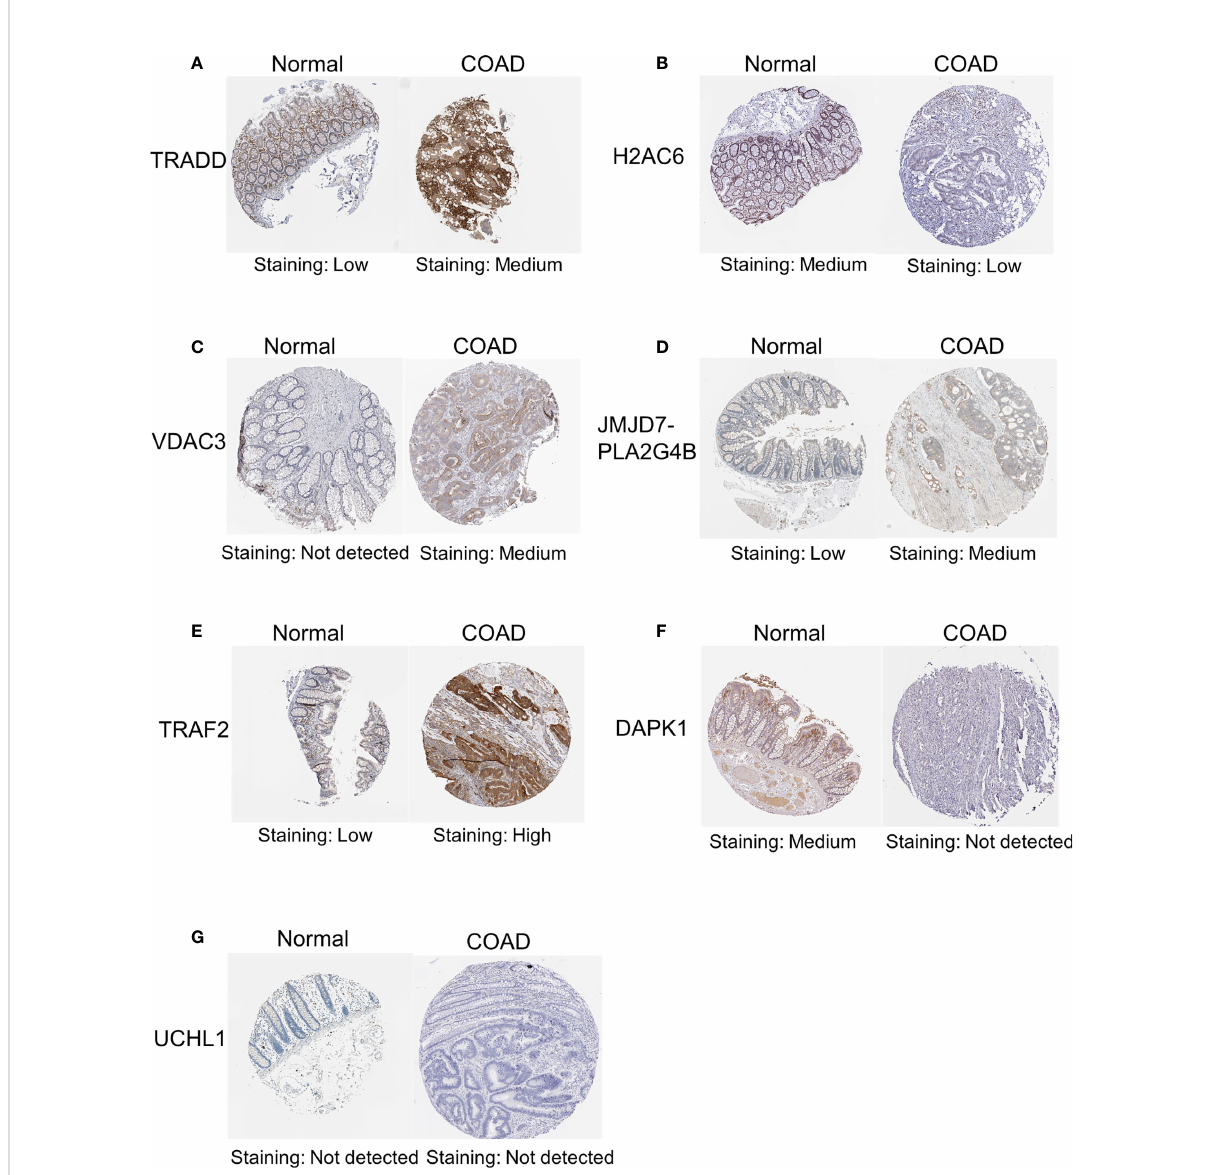
FIGURE 12 IHC analysis of the protein expression of necroptosis-related candidate genes in COAD and normal tissues in the HPA database. The protein expression levels of TRADD (A) , H2AC6 (B) , VDAC3 (C) , JMJD7-PLA2G4B (D) , TRAF2 (E) , DAPK1 (F) and UCHL1 (G) in colon cancer tissues and normal tissues in the HPA database. IHC,